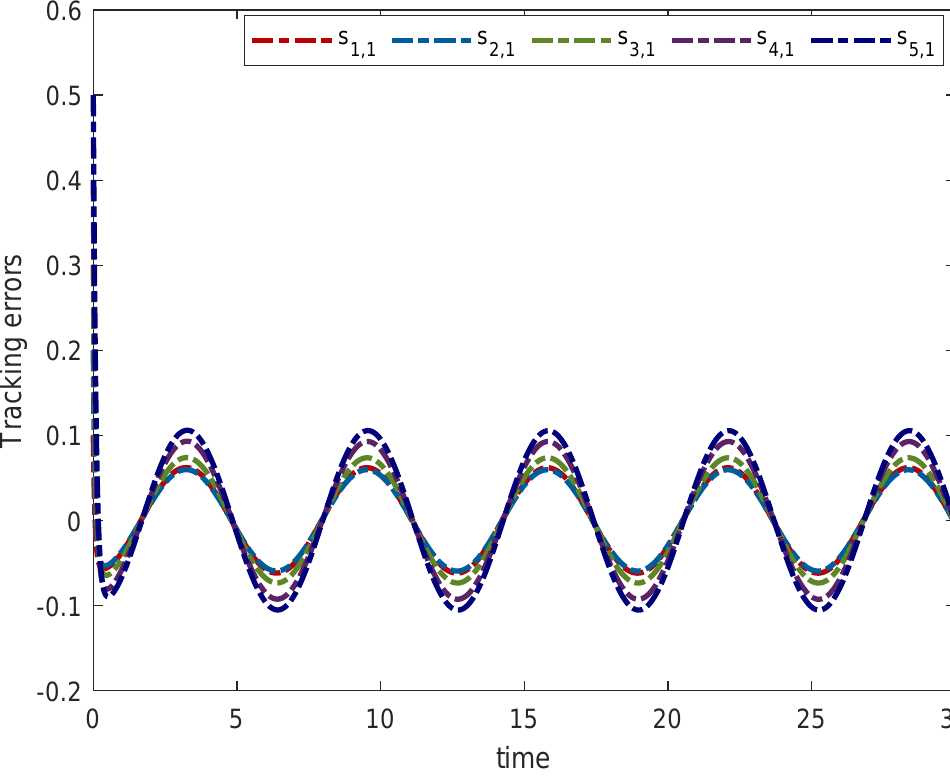
Figure 14. The trajectories of tracking error s i ,1 ( i = 1, · · · ,5 ) based on the algorithm proposed in this